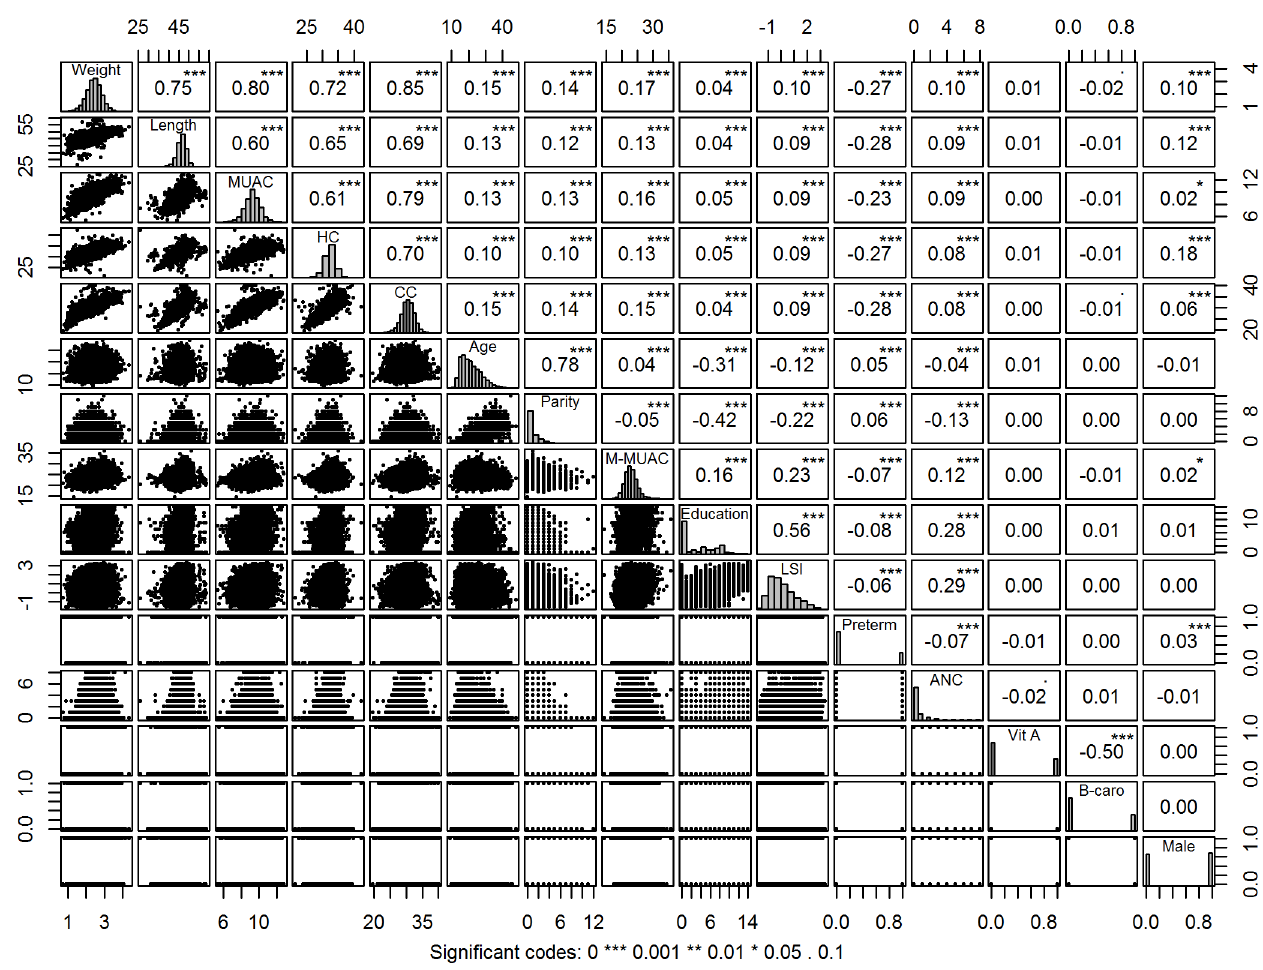
Fig 1. Pair wise correlation and scatter plot matrix of the study variables. (MUAC, Mid-UpperArm Circumference; HC, Head circumference; CC, Chest Circumference; M-MUAC, MaternalMUAC; LSI, Living StandardIndex; ANC, Antenatal care visit; Vit A, Maternal vitamin A supplementation; B-care, Maternal β -carotenesupplementation; Male, Infant’s sex as male).